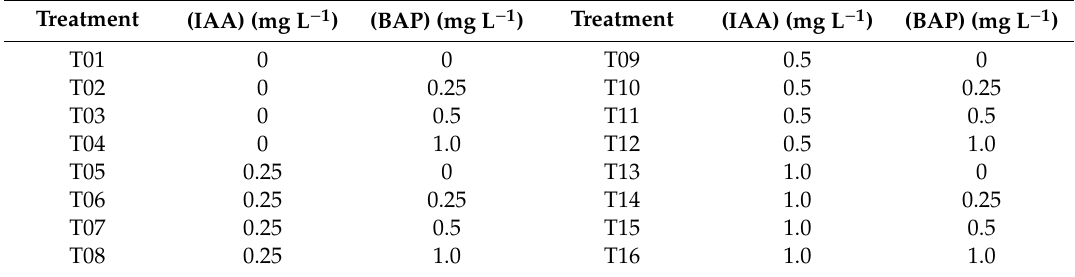
Table 1. Phytohormone treatments used for the Bryophyllum spp. organogenesis experiments. All treatments contained MS as the basal